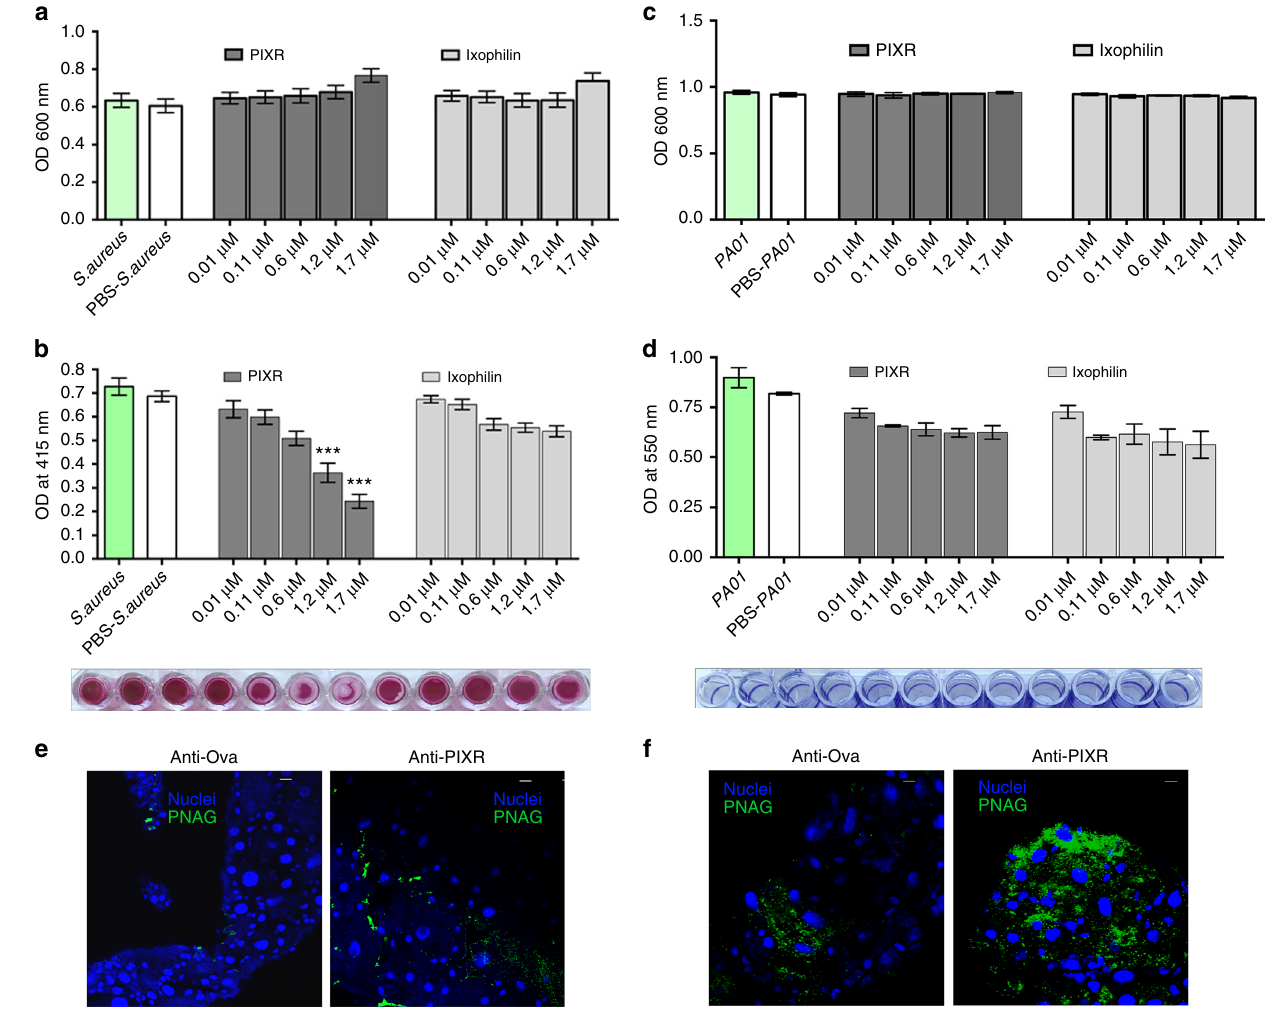
Fig. 5 PIXR in fl uences bio fi lms in vivo and in vitro. a Growth of Staphylococcus aureus cultures upon incubation with rPIXR or rIxophilin. b Bio fi lm formation of S . aureus in presence or absence of rPIXR or rIxophilin. Results are mean ± s.e.m. of three biological replicates. A representative image of the corresponding safranin-stained bio fi lm is shown below the graph. Bacteria cultured without any added recombinant protein or with PBS served as controls. Asterisks represent statistical signi fi cance determined by one-way analysis of variance. c Growth of Pseudomonas aeruginosa cultures upon incubation with rPIXR or rIxophilin. d Bio fi lm formation of P . aeruginosa in presence or absence of rPIXR or rIxophilin. Results are mean ± s.e.m. of three biological replicates. A representative image of the corresponding Crystal violet-stained bio fi lm (formed as a ring along the well-walls) is shown below the graph. Bacteria cultured without any added recombinant protein or with PBS served as controls. Visualization of poly-N-acetyl Glucosamine (PNAG) using rabbit anti- PNAG antibody: e in native bio fi lms; and f in bio fi lms formed upon injected S. aureus in guts of ticks fed for 48 h on ovalbumin-(anti-Ova) or rPIXR- immunized mice (anti-PIXR). Scale bars, 10 μ